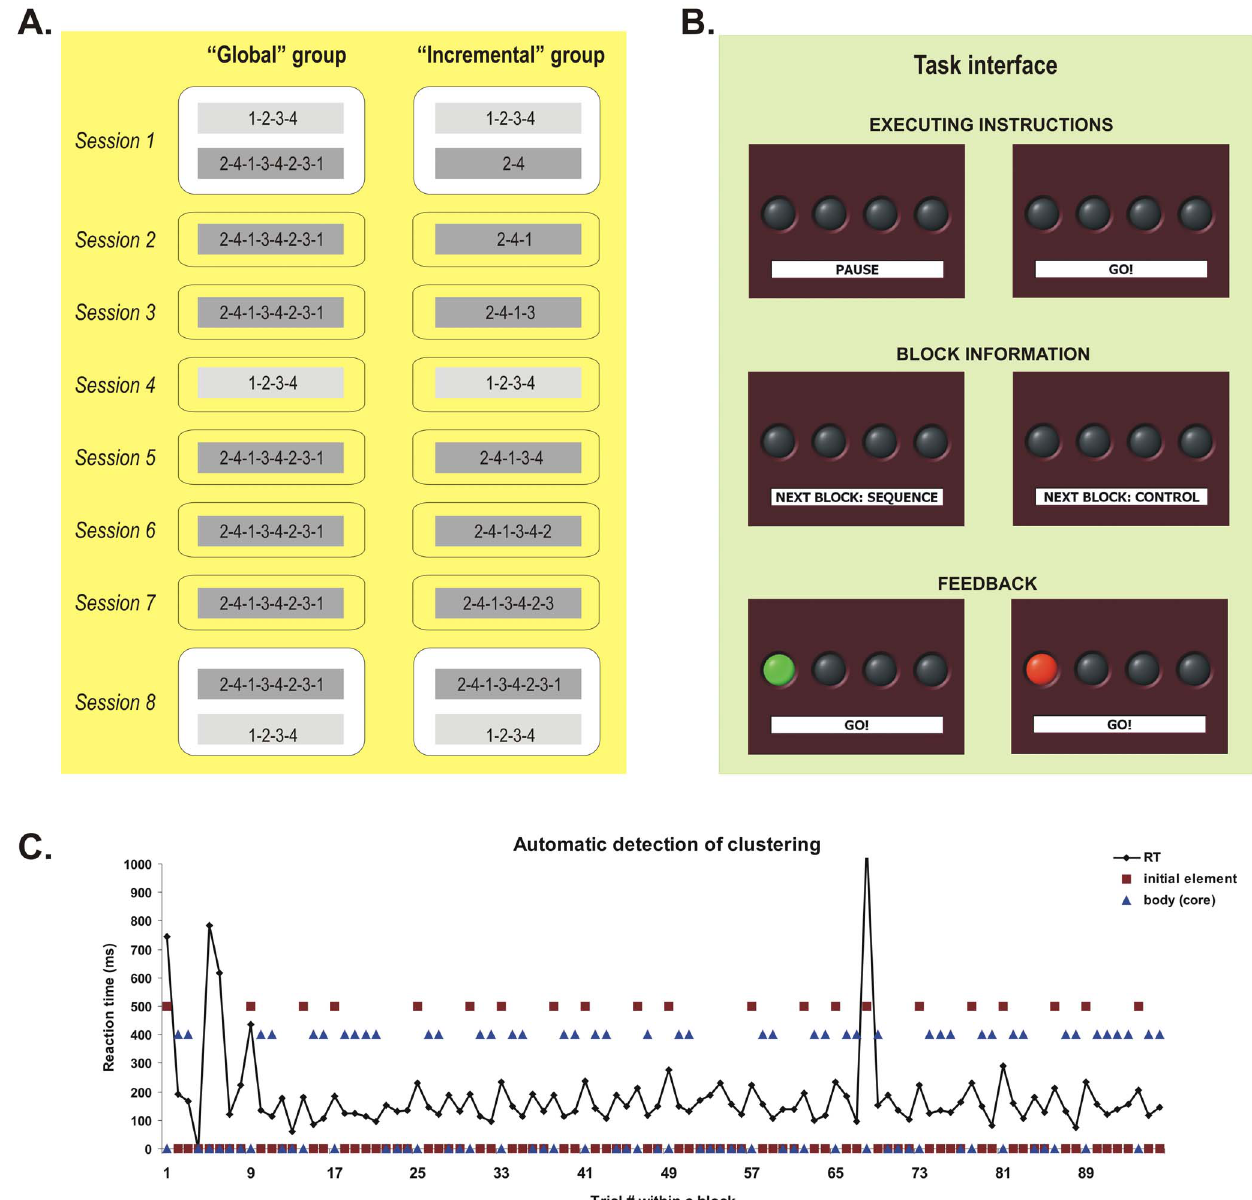
Figure 1. Experimental groups and sessions, the task and the automatic chunking procedure. A. Control (light gray) and target (dark gray) sequences practiced by the two groups of subjects across training sessions. The numbers 1 to 4 correspond to four fingers of the left hand, from the little (1) to the index (4) finger. B. The task interface presenting the executing instructions, the block information and the type of feedback after each trial. C. Reaction time (RT) in a block for a given subject and the classification of trials into initial element of a chunk (red squares) and the body or core of the chunk (blue triangles) by our automatic clustering algorithm.